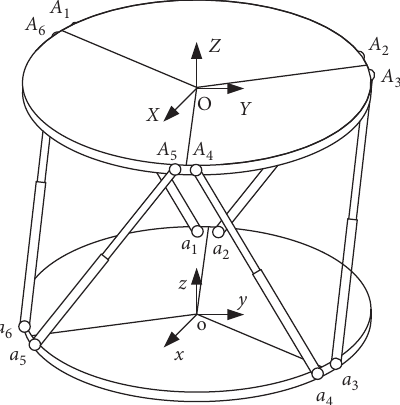
Figure 1: Stewart 6-DOF platform geometrical structure